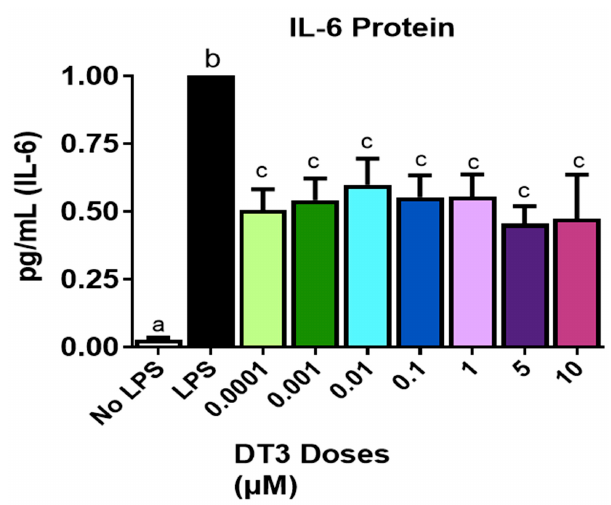
Figure 3. Delta-Tocotrienol decreased IL-6 secretion: All doses of DT3 significantly reduced IL-6 secretion measured in 3T3-L1 cells compared to the LPS control. Means with different letters (a, b, c) are significant. n = 6, p < 0.05.